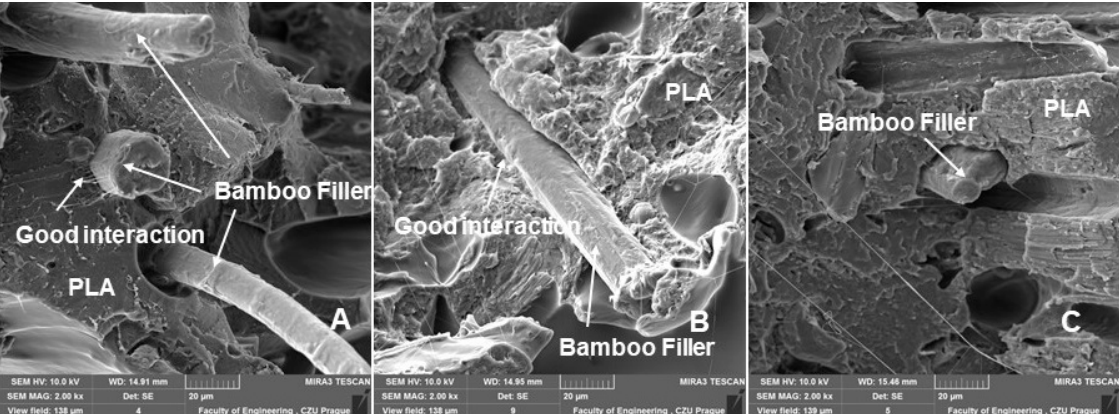
Figure 10. SEM images—fractographic analysis (MAG 2.00 kx): ( A ): nozzle 0.4 mm, infill density 60%, static test; ( B ): nozzle 0.4 mm, infill density 80%, static test; ( C ): nozzle 0.6 mm, infill density 100%, low cyclic fatigue.